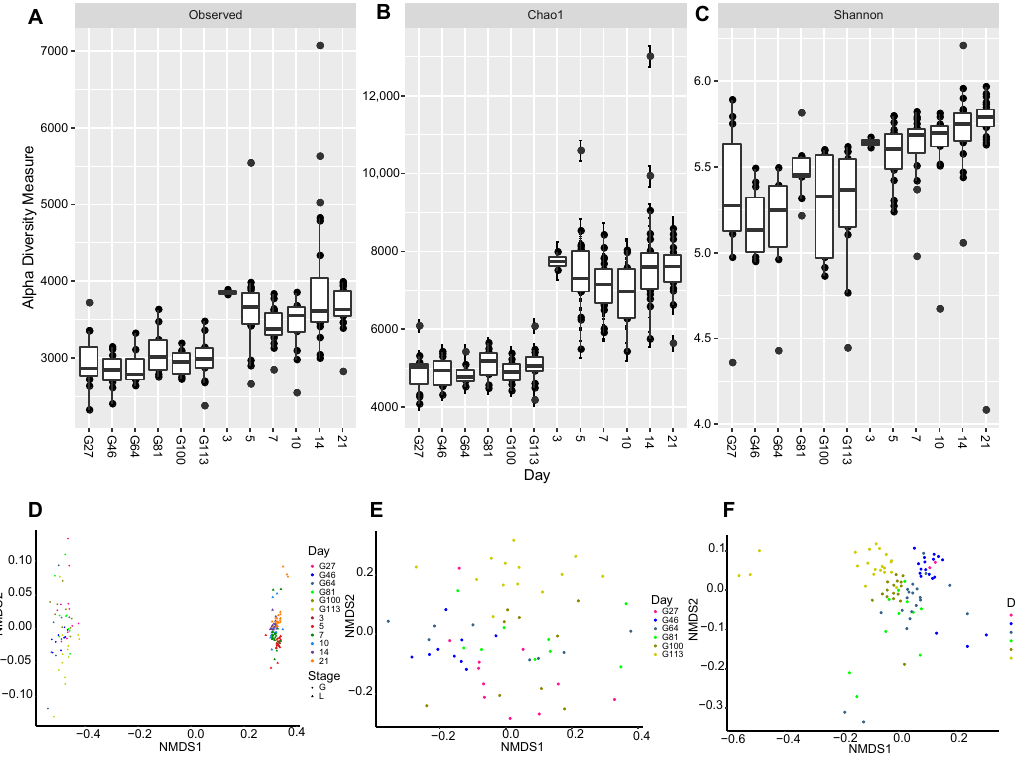
Figure 1. Changes in the microbiome biodiversity in the perinatal period. ( A ) Bacterial alpha diversity determined by the observed OTU index. ( B ) Bacterial alpha diversity determined by the Chao